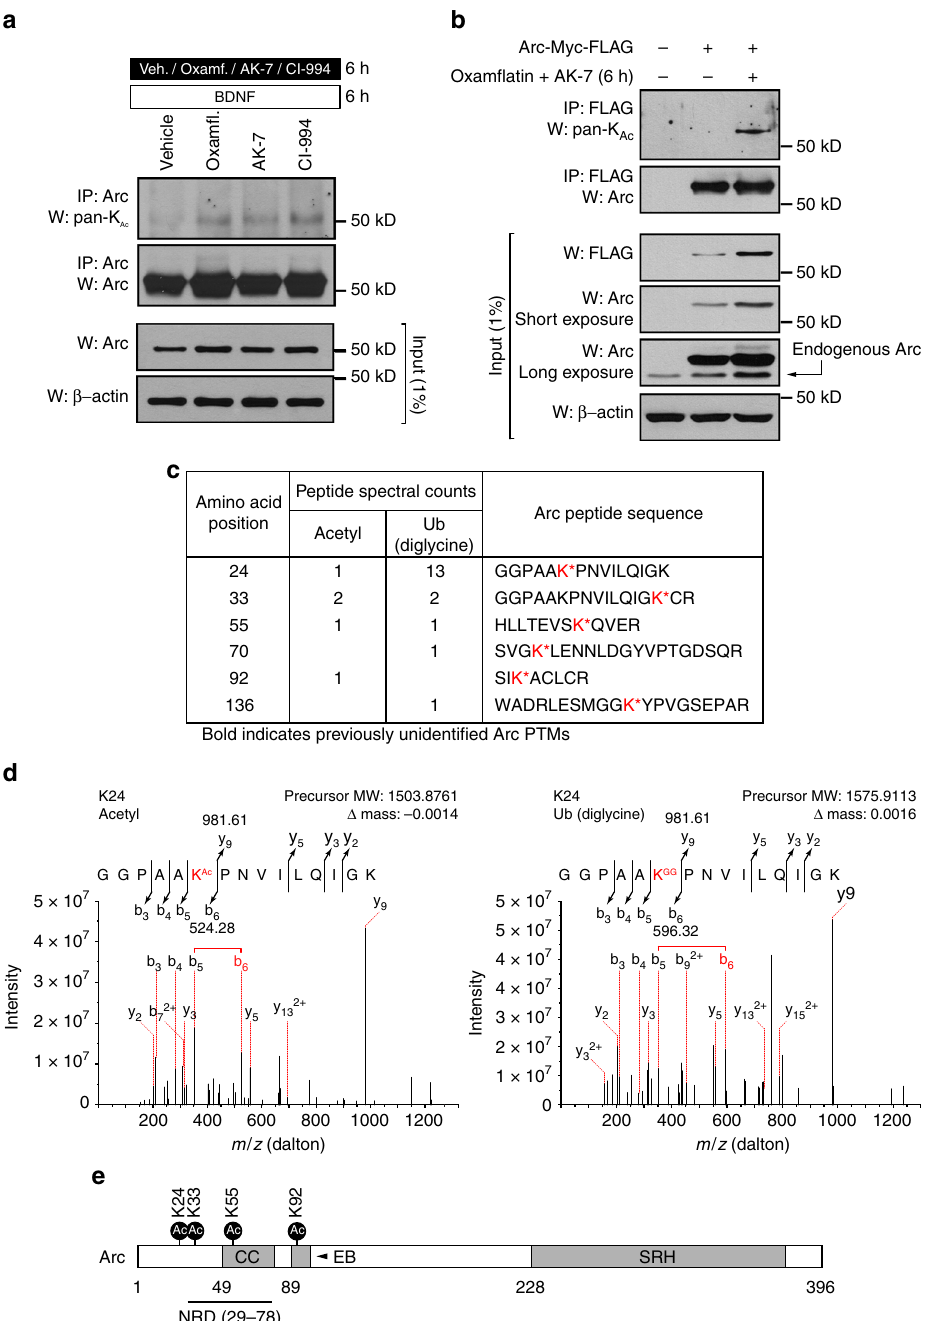
Fig. 6 Arc is acetylated at different lysine residues. a Arc was immunopuri fi ed from lysates of primary cortical neurons co-treated for 6 h with BDNF and vehicle, AK-7, oxam fl atin, or CI-994 as indicated. Immunoprecipitates were analyzed by western blot with an anti-acetyl-lysine antibody to reveal acetylated Arc. b Overexpressed mouse Arc-Myc-FLAG was immunopuri fi ed from Neuro2a cells treated as indicated. Immunoprecipitates were analyzed as in a . Acetylated Arc-Myc-FLAG was only detected from the Neuro2a cell lysate co-treated with oxam fl atin (16.7 µ M) and AK-7 (16.7 µ M). c Table summarizes all acetylated and ubiquitinated (revealed as diglycine (GG) modi fi cation) lysine residues of Arc-Myc-FLAG immunopuri fi ed from overexpressing Neuro2a cells detected by MS/MS. The acetylated and/or ubiquitinated lysine residues in the isolated Arc tryptic peptides are presented in red (K*). d Representative product ion spectrum of MS/MS fragmentation supporting acetylation (left) and ubiquitination (right) of Arc lysine residue 24. e Schematic representation showing distribution of acetylated lysine residues over mouse Arc protein domains (CC coiled-coil, EB endophilin-3 binding region, NRD nuclear retention domain, SRH spectrin repeat